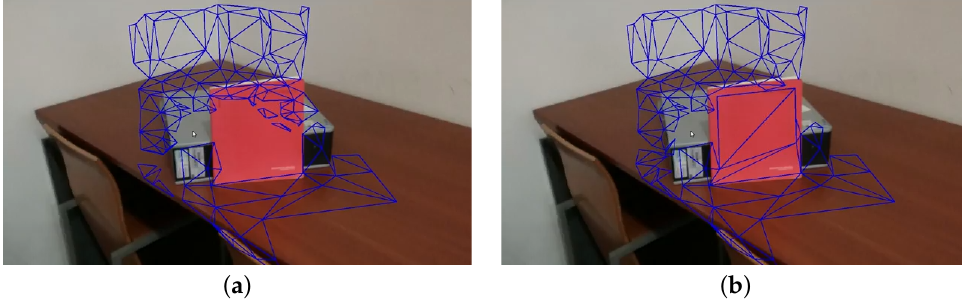
Figure 4. Instantaneous snapshots of the z-buffering procedure: ( a ) before processing the faces on the red book, the faces behind the book are included in the list of non-occluded faces; ( b ) the faces containing the red book are processed and, since they occlude the faces discussed in ( a ), these are